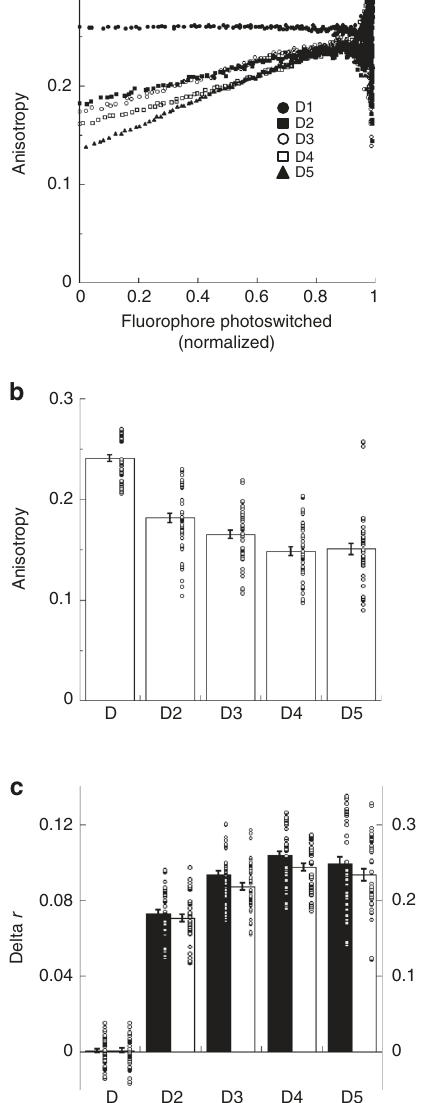
Fig. 3 psAFRET measurements of Dronpa fl uorescent protein oligomers. a COS-7 cells expressing Dronpa (black circles), D2 (black squares), D3 (white circles), D4 (white squares), or D5 (black triangles) were imaged and photoswitched. The anisotropy was determined and displayed as a function of the fl uorophore photoswitched. b The conventional steady-state anisotropy for each chimera was determined from the fi rst data points of the photoswitching experiment. ANOVA indicated signi fi cant differences for all comparisons except D3-D5 and D4-D5 ( p -value < 0.05). Cohen ’ s d values ranged 0.54 – 3.12. Data represent mean ± sem ( n = 45). c The data points representing ~80% of the fl uorescence were fi tted to linear equations for experiments performed and analyzed as shown in ( a ). These were used to determine the anisotropy before and after photoswitching. The difference in anisotropy (delta r, black columns) is shown compared with its conversion to drFRET ef fi ciency (white columns) using Eq. (2). ANOVA indicated signi fi cant delta r differences for all comparisons except D3-D5 and D4-D5 ( p -value < 0.05). Cohen ’ s d values ranged 0.62 – 6.44. ANOVA indicated signi fi cant drFRET differences for all comparisons except D3-D5 and D4-D5 ( p -value < 0.05). Cohen ’ s d values ranged 0.7 – 6.74. Data represent mean ± sem ( n = 45). Circles overlaid on columns in the bar graphs represent individual data points. Source data are provided as a Source Data fi